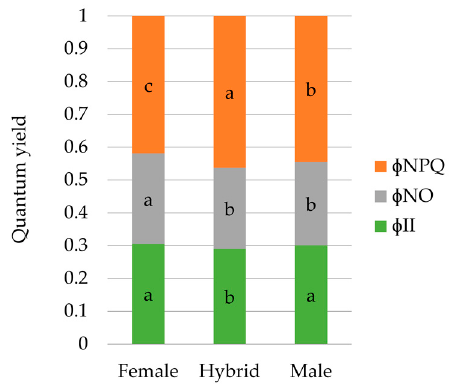
Figure 2. Di ff erences in energy allocation proportions between genotypic sets (hybrids of both females combined). Each bar represents the unit, and is split in three parts in terms of the complementary quantum yields of PSII: ( 1 ) quantum yield of photochemical energy conversion in PSII ( φ II ), ( 2 ) quantum yield of non-regulated non-photochemical energy loss in PSII ( φ NO ), and ( 3 ) quantum yield of regulated non-photochemical energy loss in PSII ( φ NPQ ). Each bar represents mean values of energy partition for each genotypic set. Values of the same variable designated with di ff erent letters are significantly di ff erent at P < 0.05 according to the contrast performed for the overall ANOVA.